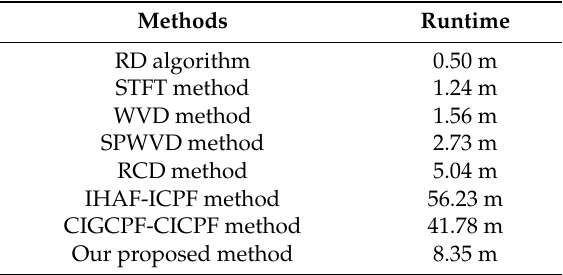
Table 3. Computational complexity comparisons.